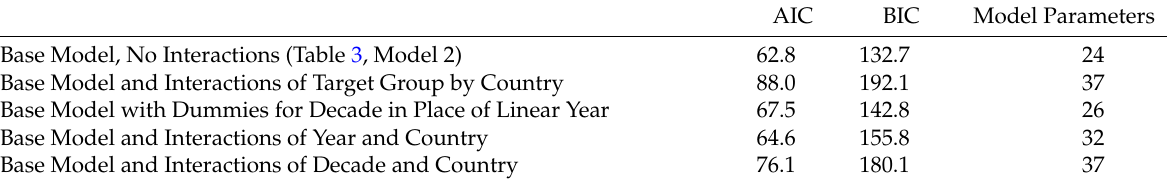
Table 4: Fit statistics for models with interactions and alternative specifications. Base Model, No Interactions (Table 3, Model 2) Base Model and Interactions of Target Group by